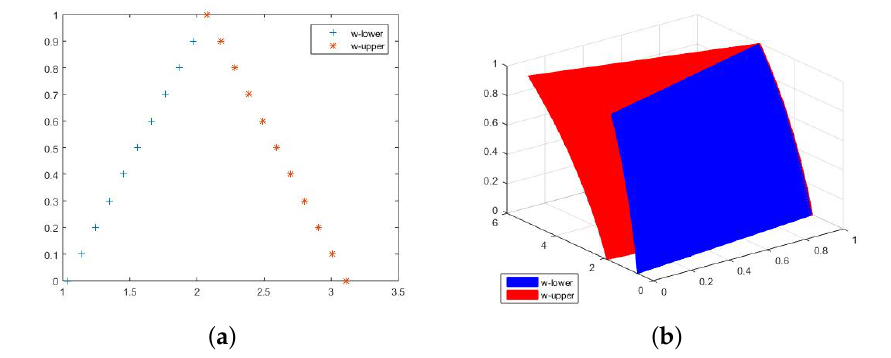
Figure 3. The approximate lower and upper solutions of Equation (144) at Λ = 0.5, t = 2, (cid:61) = 1/2, ı = 1. ( a ) 2 D figure for the approximate solutions of one-dimensional fuzzy fractional diffusion equation of w in Example 8. ( b ) 3 D figure for the approximate solutions of w in Example